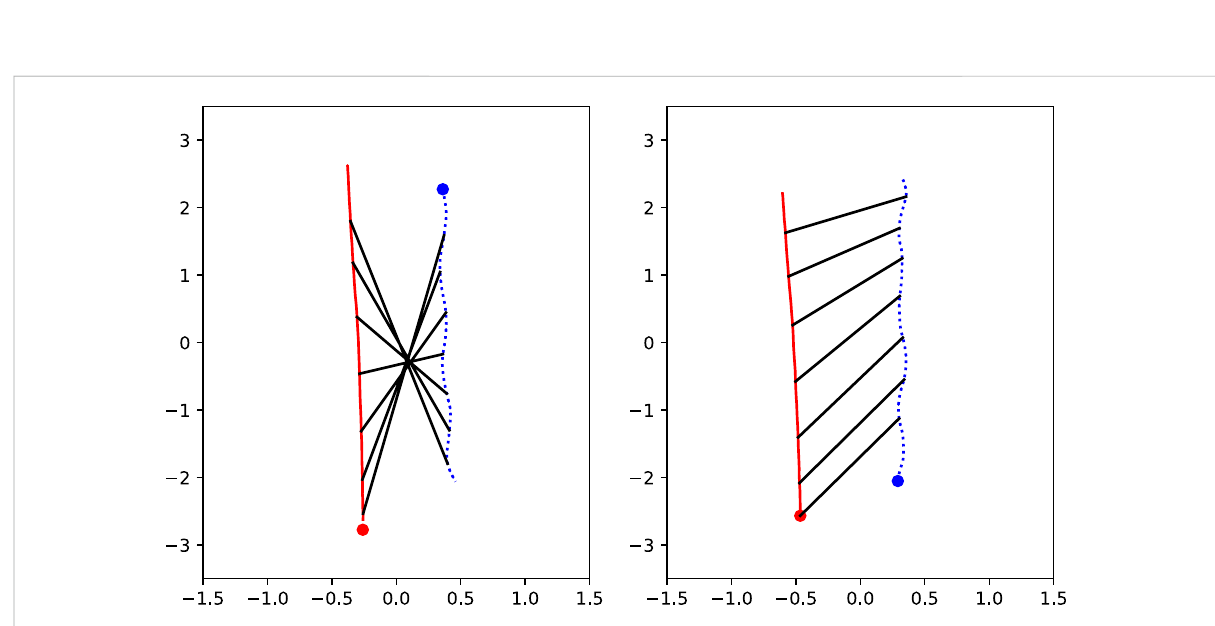
FIGURE 12 Examples of location data. The red solid line represents the path of the robot, with the dot as starting location. The blue dotted line represents the path of the participant, with the dot as starting location. The black lines represent the relative location of the actors with respect to each other. The numbers on theaxesrepresent meters. Ontheleftside, apassing scenario is shown with apassing distance of60 cmand a robot moving speed of 1.7 m/s, and on the right side, an overtaking scenario is shown with a distance of 80 cm and a robot moving speed of 1.7